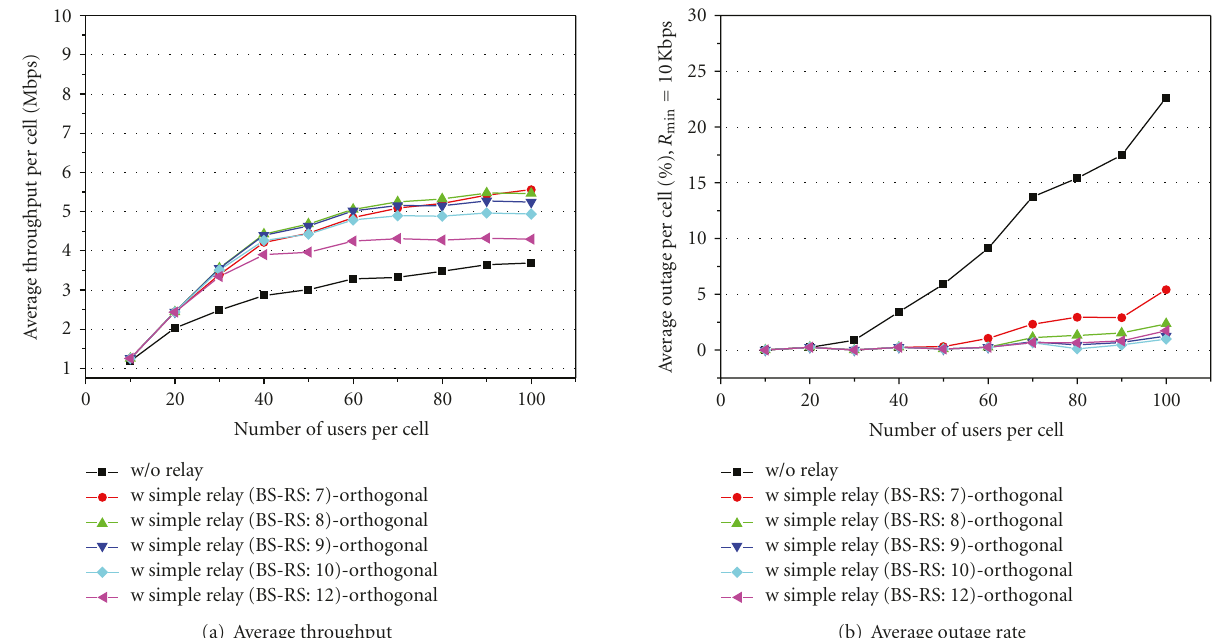
Figure 5: Average throughput and outage performance for a multihop relay with orthogonal allocation. number of symbols assigned for the relay link, to search for with the number of symbols allocated for the relay and the boundary that maximizes the average system throughput access links. In Figure 5, for example, a boundary with 14 for the given number of MSs in each cell. symbols for the relay link performs best for the overlapped allocation. Meanwhile, 8 symbols for a relay link roughly seem to be the best choice for the orthogonal allocation in Figure 6. For 100 mobile stations, the average throughput can be improved as much as 92% with the relay system using